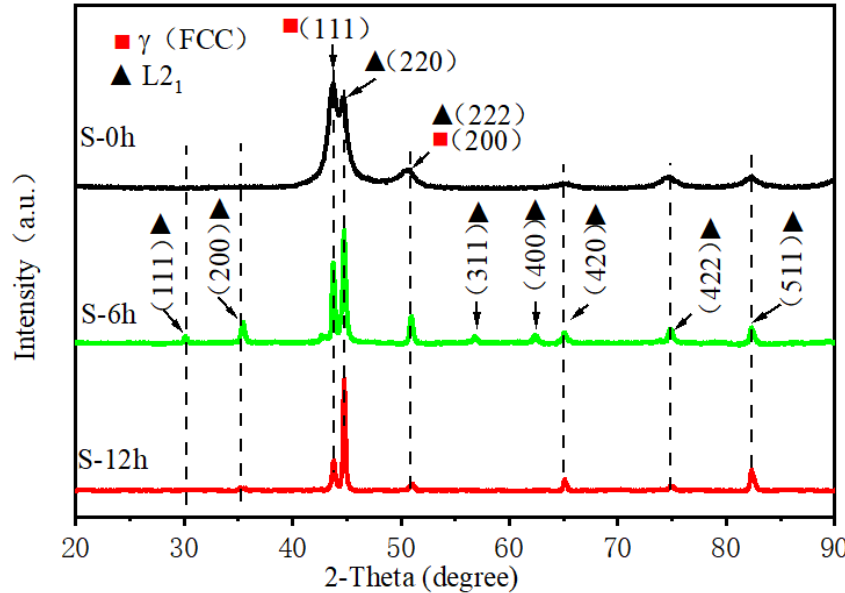
Figure 2. XRD pattern of three samples for NiCoMnSn alloy flakes.